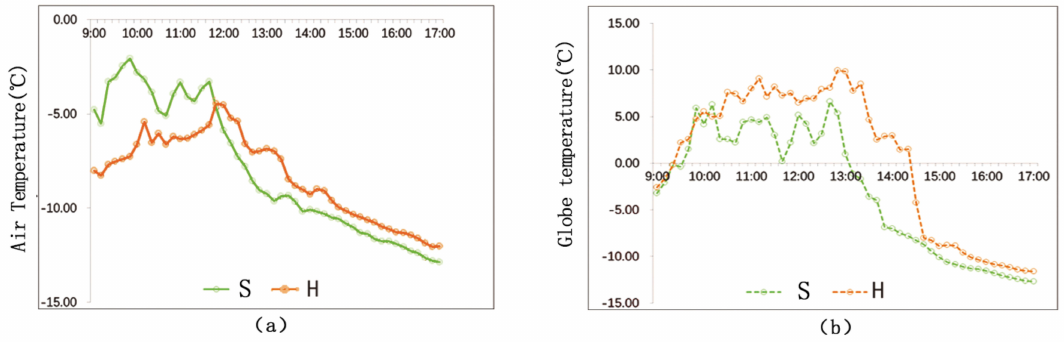
Figure 16. Temperature comparison at points S and H: ( a ) Ta; ( b )